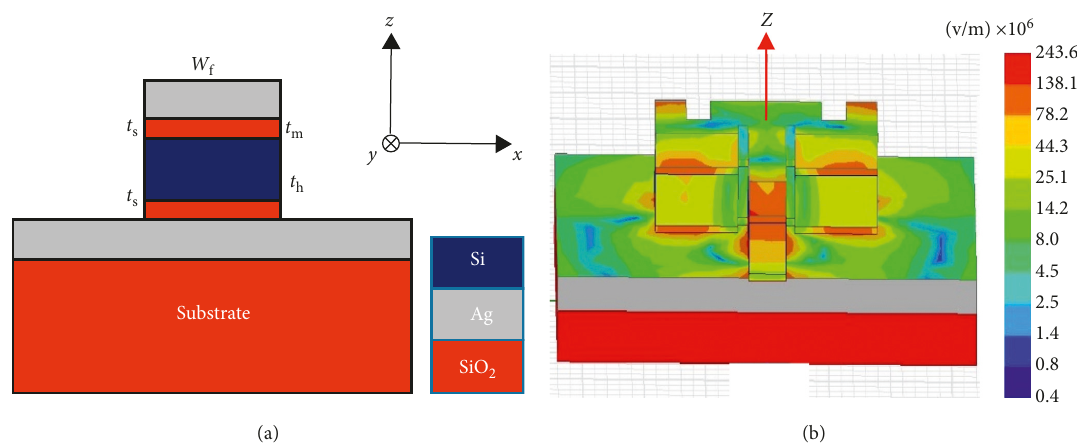
Figure 1: HMIM plasmonic feed waveguide. (a) Cross-sectional view. (b) 3D electric field